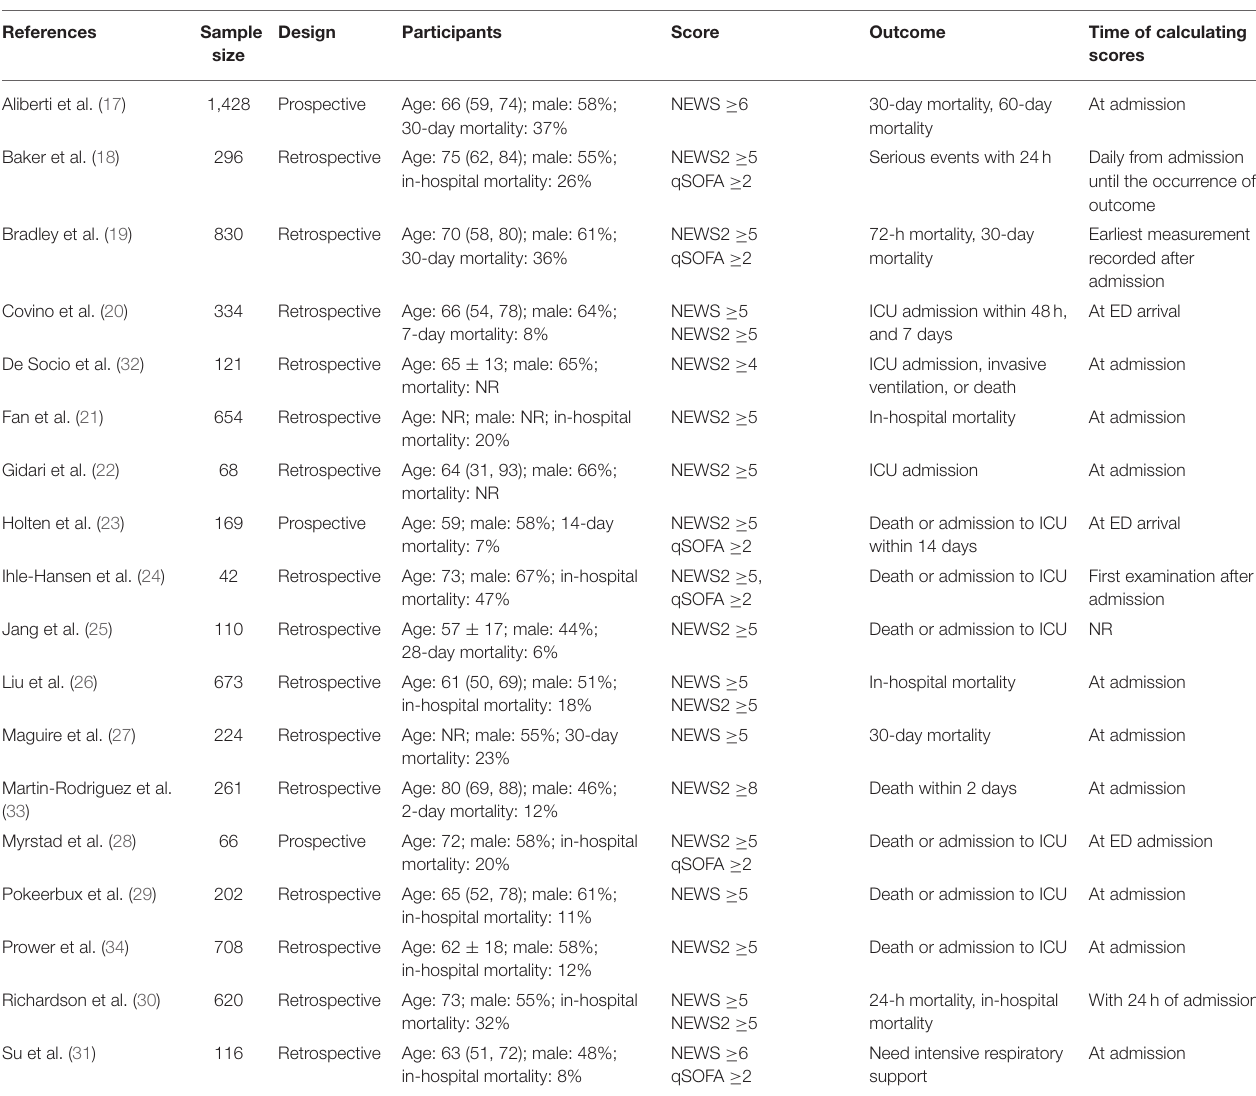
TABLE 2 | Characteristics of the included